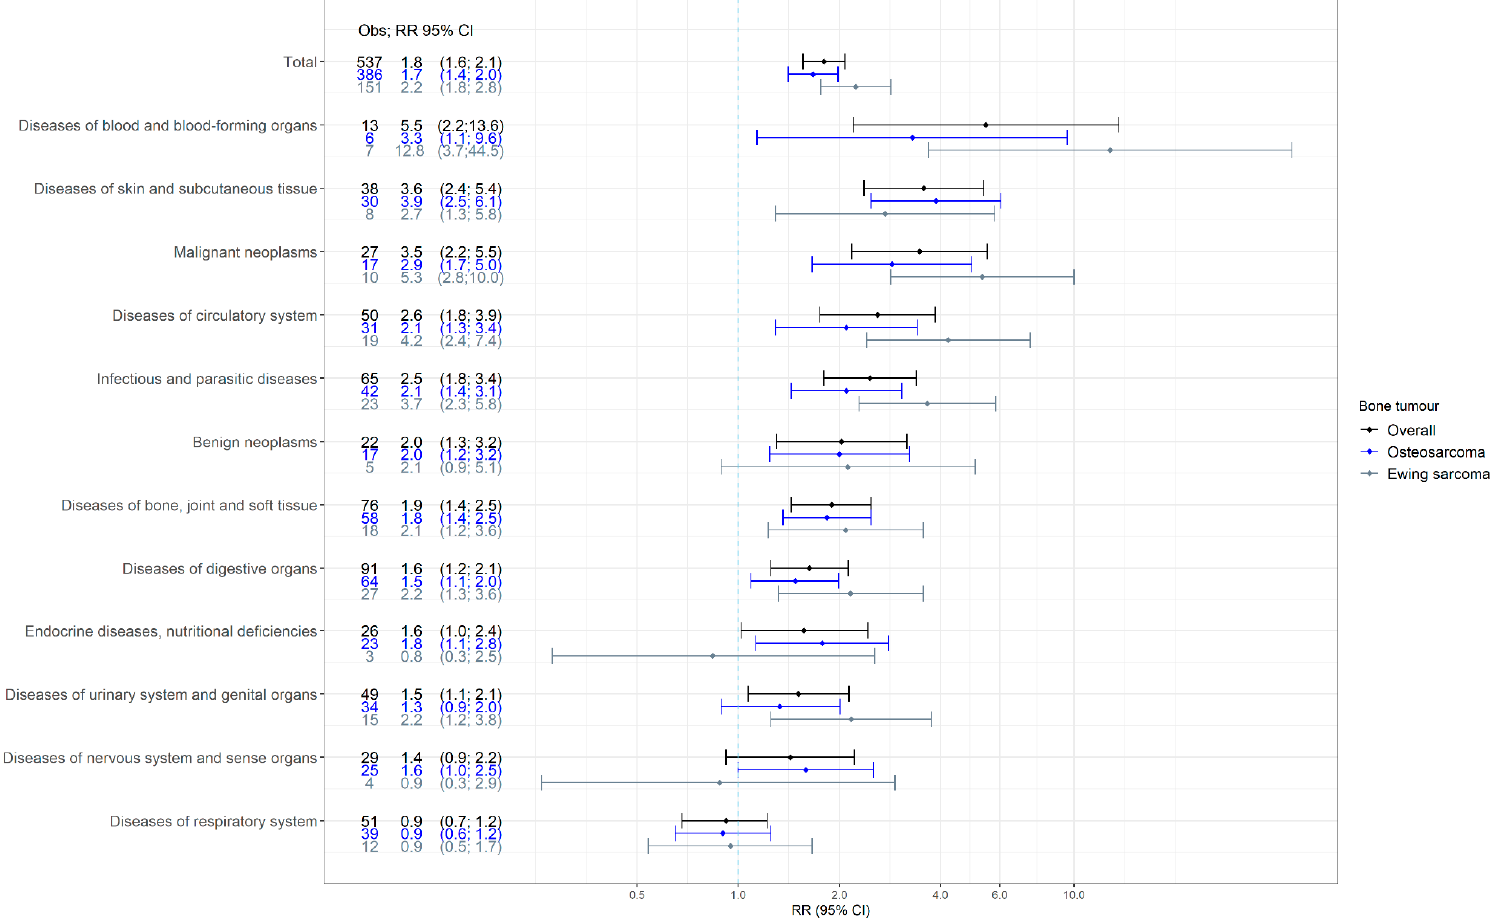
Figure 2. Rate ratios (RRs) and 95% confidence intervals (CIs) for hospital contacts for the 12 main diagnostic groups among survivors of a malignant bone tumor and stratified by osteosarcoma and Ewing sarcoma. Obs: observed number of hospital contacts by survivors.